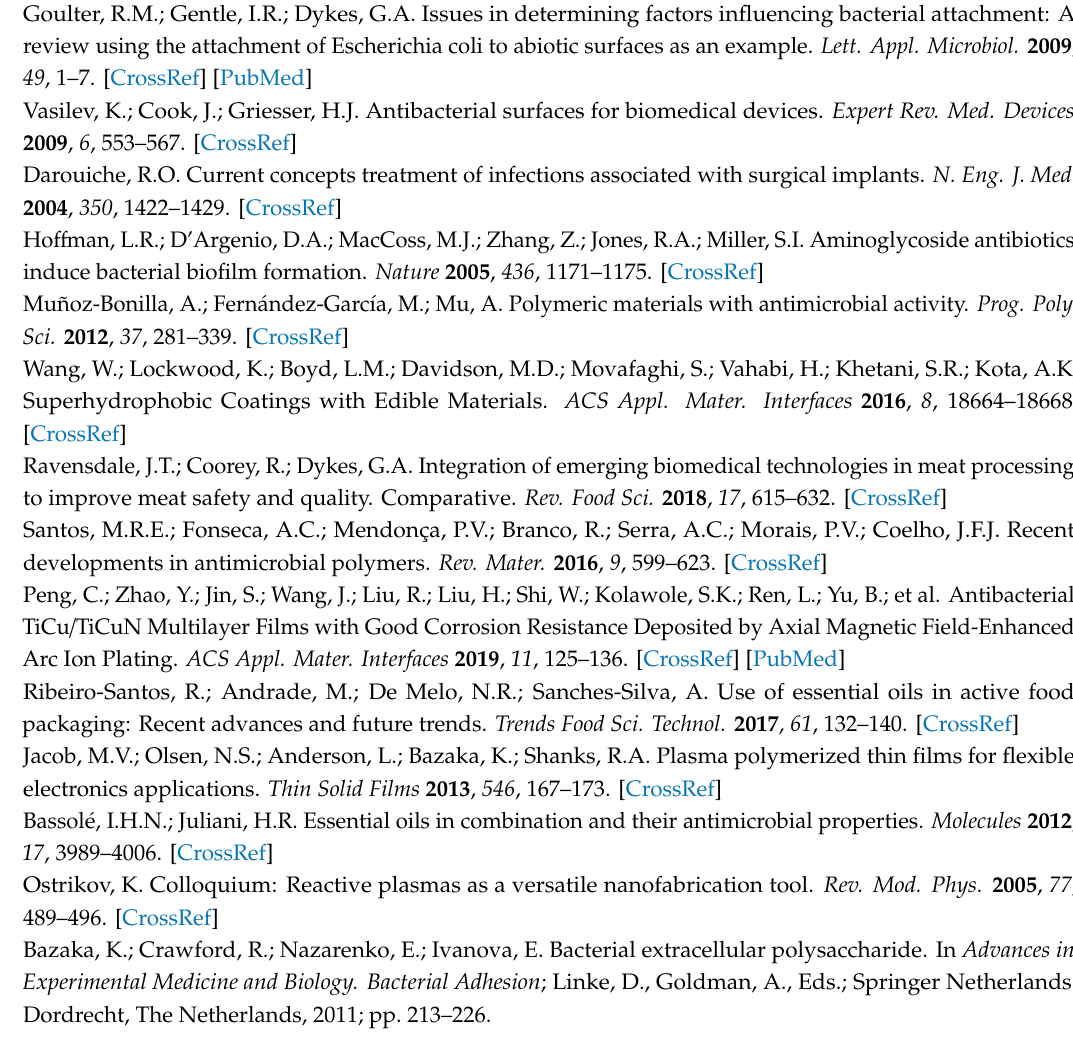
Figure S1: Scanning electron micrographs of (a) stainless steel and of the film deposited at 30 min deposition time and 3 L / min gas flow rate (b) at 0.68 W and (c) at 0.86 W; Figure S2: EDS map of the film deposited at 0.77 W and 5 L / min gas flow rate for 45 min deposition time; Figure S3: The water contact angles, measured before and after aging for 35 days under ambient conditions, for films derived from carvacrol at 0.6 W and 5 L / min gas flow rate under di ff erent deposition times; Figure S4: FTIR spectra of (a) and (b) direct coating of carvacrol monomer, and (c) and (d) carvacrol thin film deposited at 0.54 ± 0.04 W and 4 L / min flow for 30 min deposition time on stainless steel substrate; Figure S5: FTIR spectra of plasma deposited carvacrol film deposited at 0.54 ± 0.04 W and 4 L / min gas flow rate for 10 and 45 min deposition times, measured before and after aging for 35 60 to 90 and 120 days under ambient